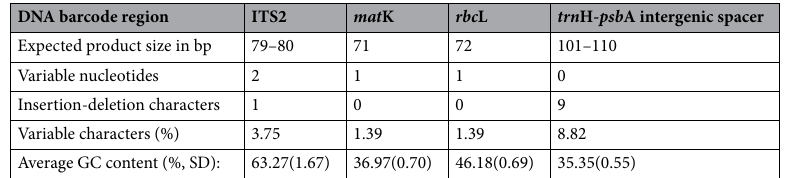
Table 2. Characteristics of the Bar-HRM amplicons from the four Mitragyna species. bp-base pair. SD-standard deviation.